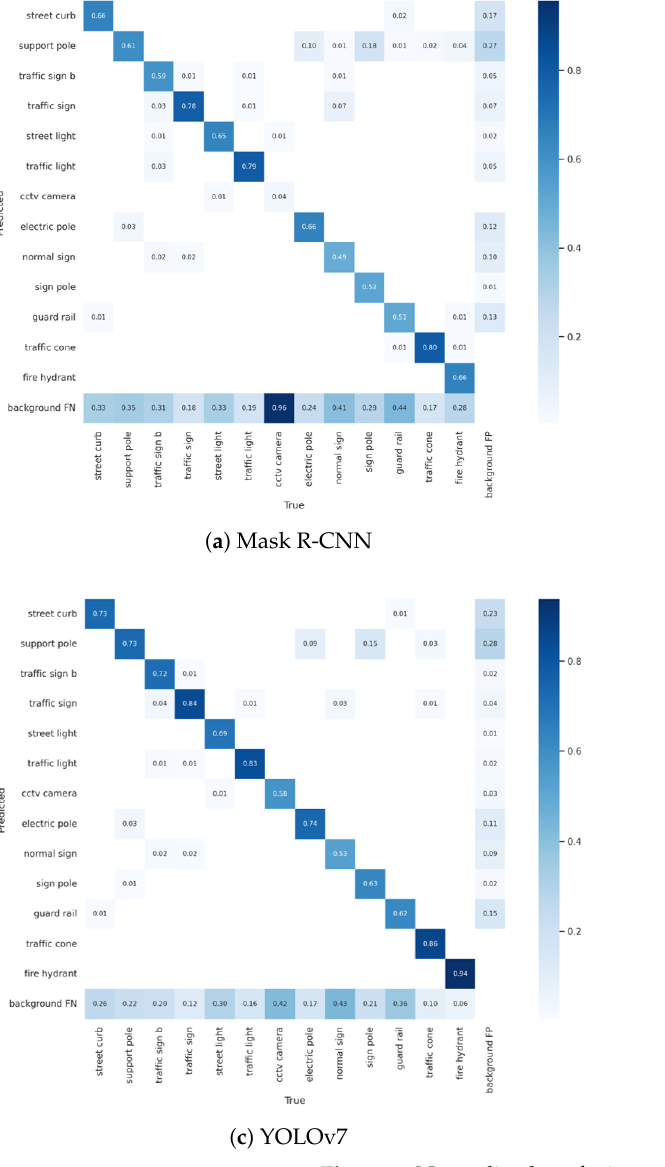
Figure 5. Normalized confusion matrices of detection results.